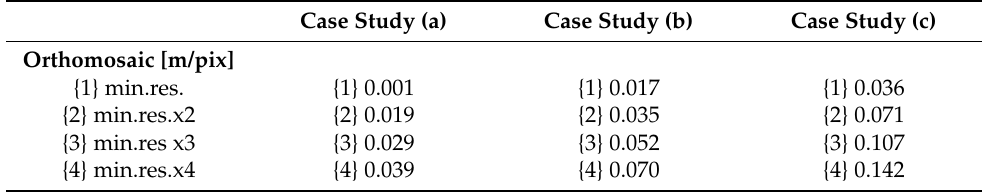
Table 3. List of spatial resolution solutions generated per scenario. The GSD values below represent an approximation to the nearest millimetre of the effective values. Case Study (a) Case Study (b) Case Study